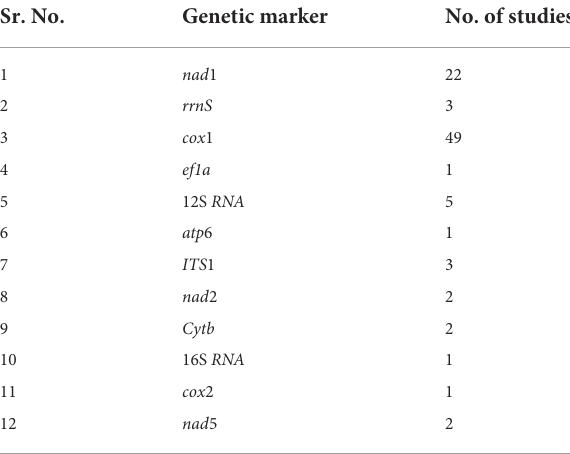
TABLE 2 Different markers were used to investigate the prevalence of Echinococcus species and a corresponding number of studies covered in this